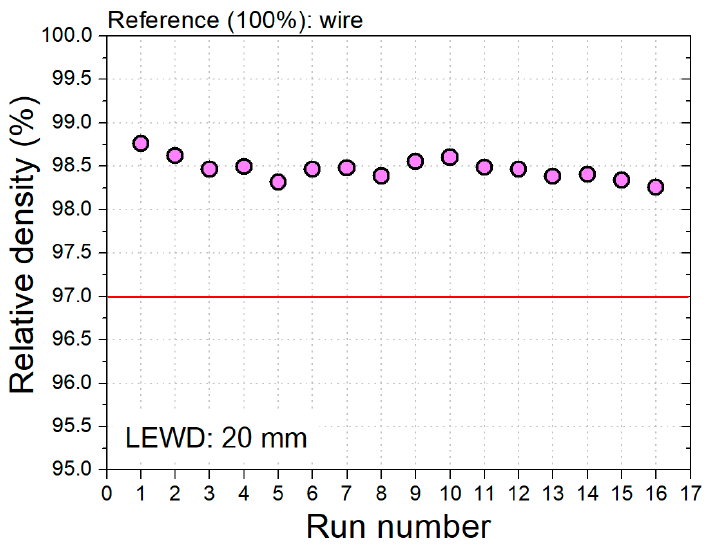
Figure 8. Relative density of the preforms produced according to Table 3 (acceptance criteria: Above the red line).